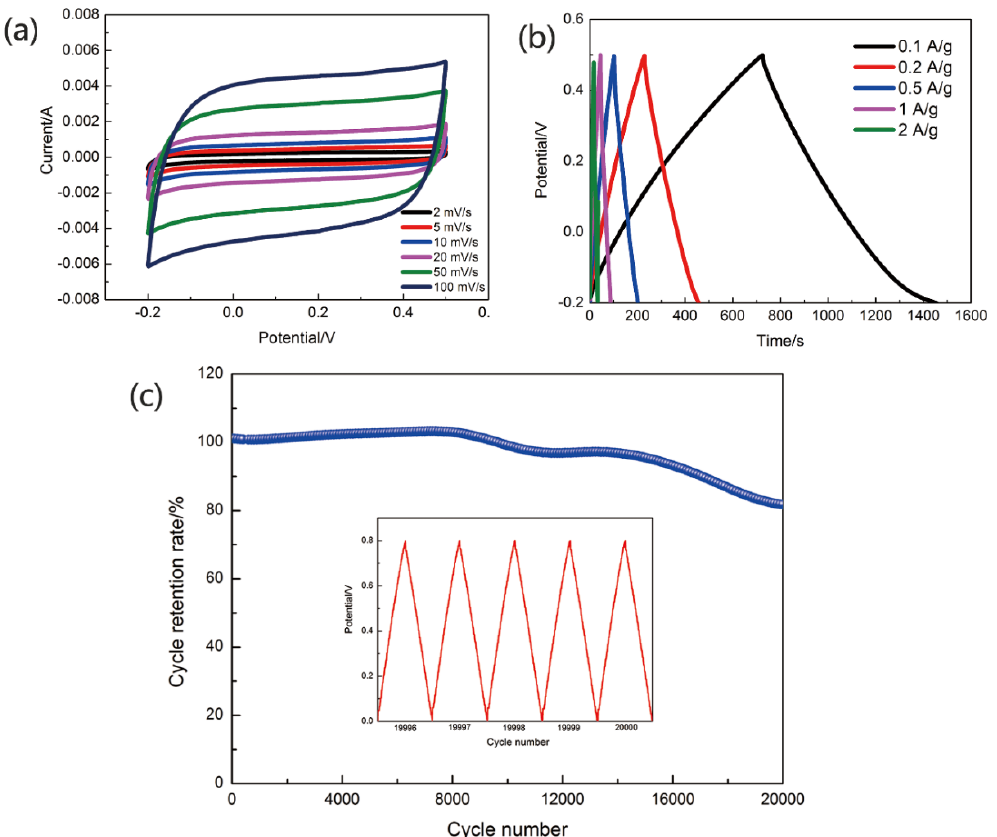
Materials 2020 , 13 , x FOR PEER REVIEW